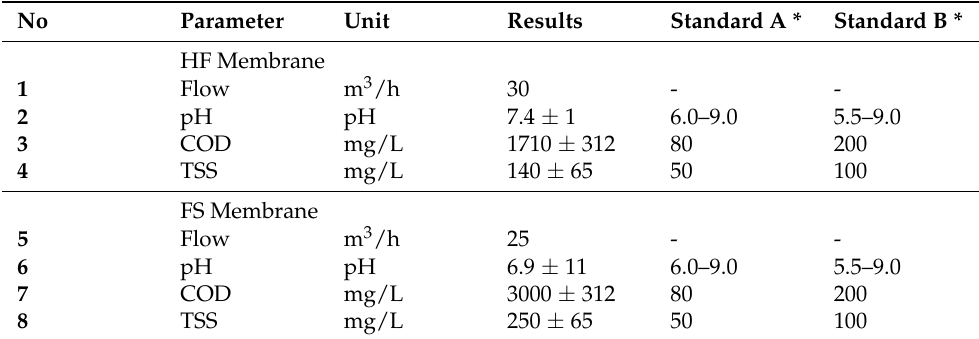
Table 4. Raw wastewater characteristics of the influent of an EQ tank for two different membrane configurations.